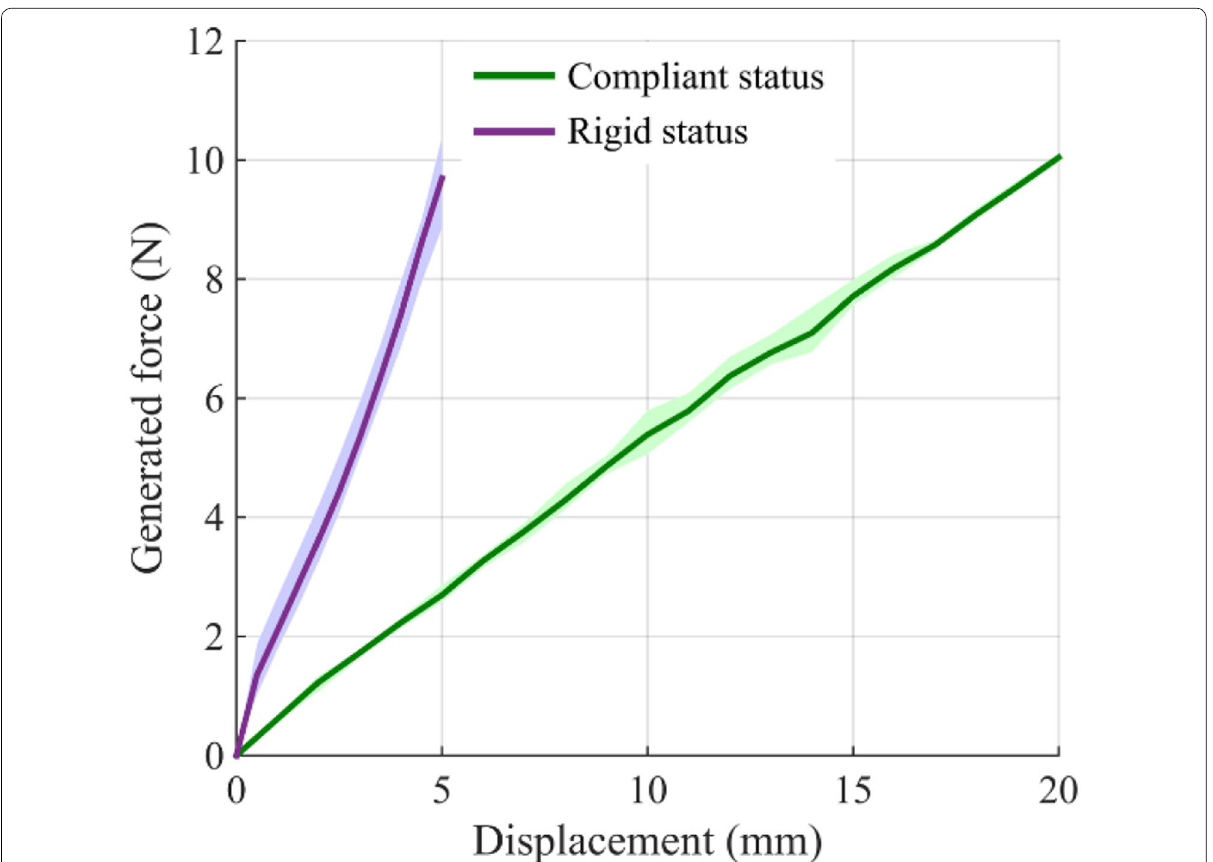
Figure 10 Correlations between the generated forces and the displacements under two